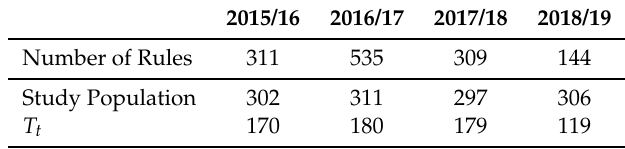
Table A4 details the number of rules extracted per year using minsup = 0.3, and minconf = 0.3. Table A4. Rule extracted for 2015/16, 2016/17, 2017/18, and 2018/19, minsup = 0.3, minconf =